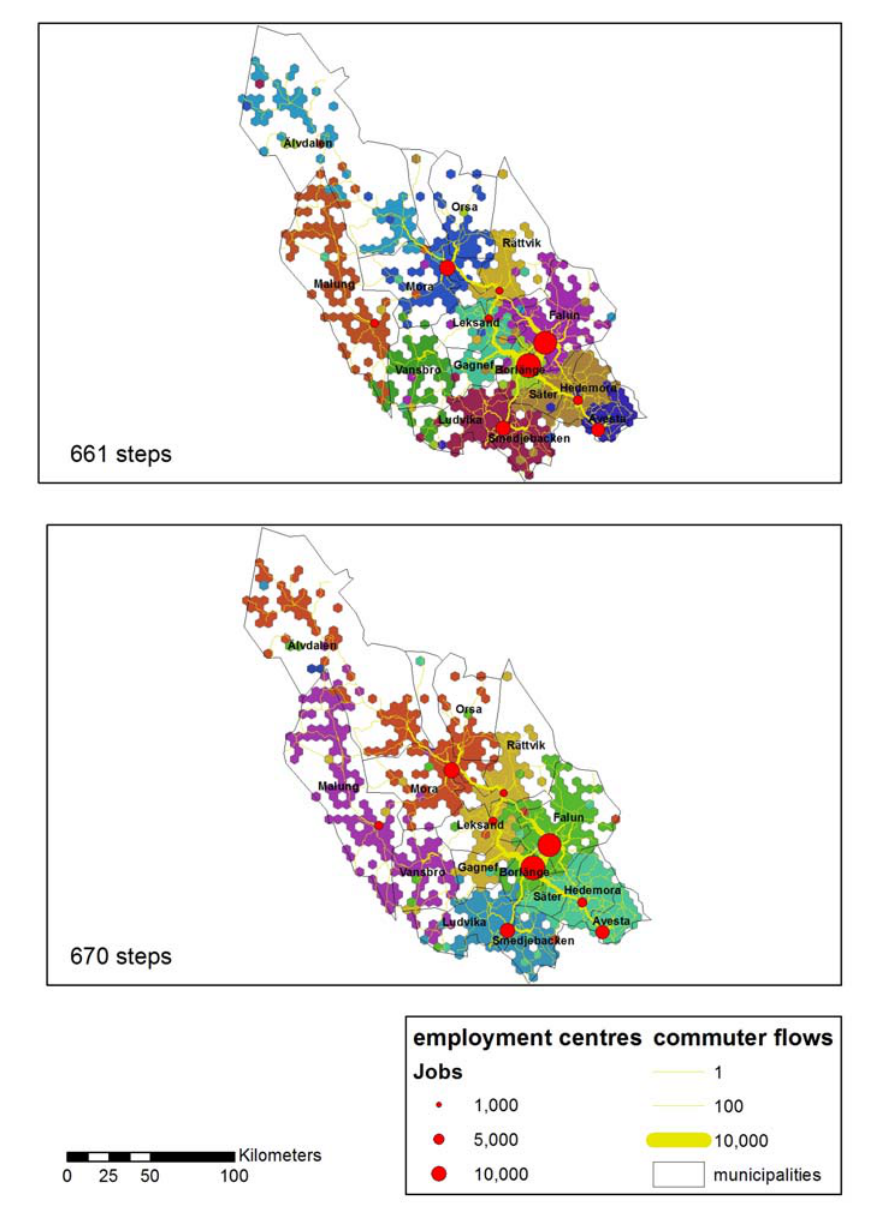
Figure 5. Intramax analysis results at steps 661 (11 regions) and 670 (six